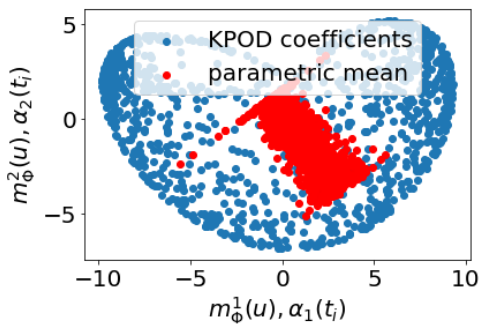
Figure 17. (Data-targeted VAE) First component ( left ) and second component ( right ) of log ( s 2 ( µ h ( t i ) , Φ )) with respect to the time step i = 1, . . . , M .